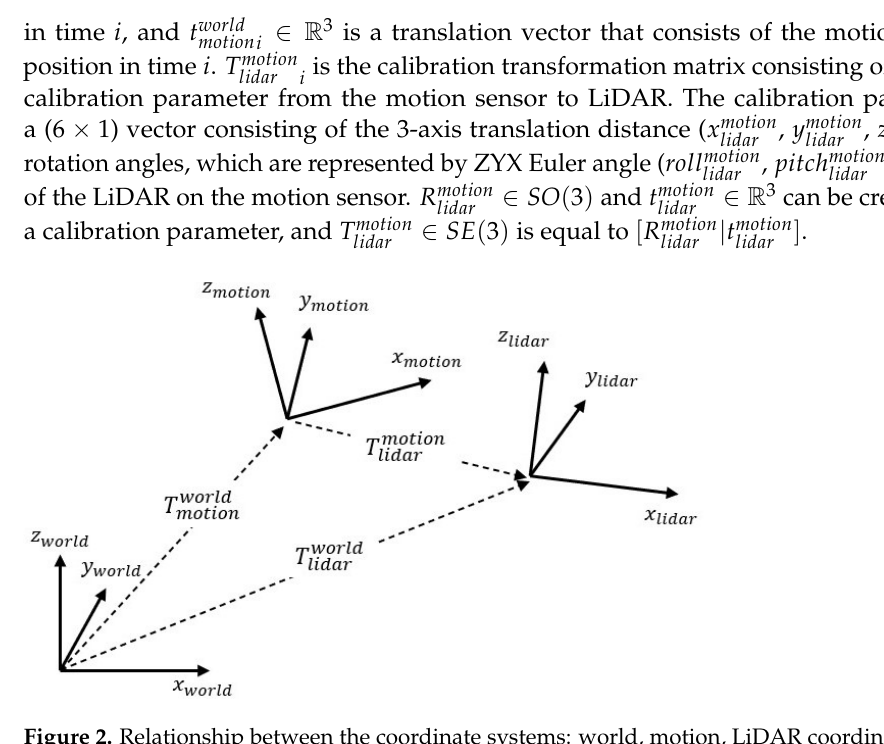
Figure 2. Relationship between the coordinate systems: world, motion, LiDAR